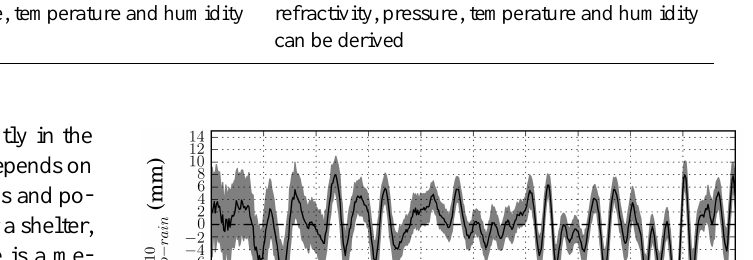
(cid:12) (cid:12) (cid:49)(cid:56) PRN ((cid:15)) (cid:12) day corrected